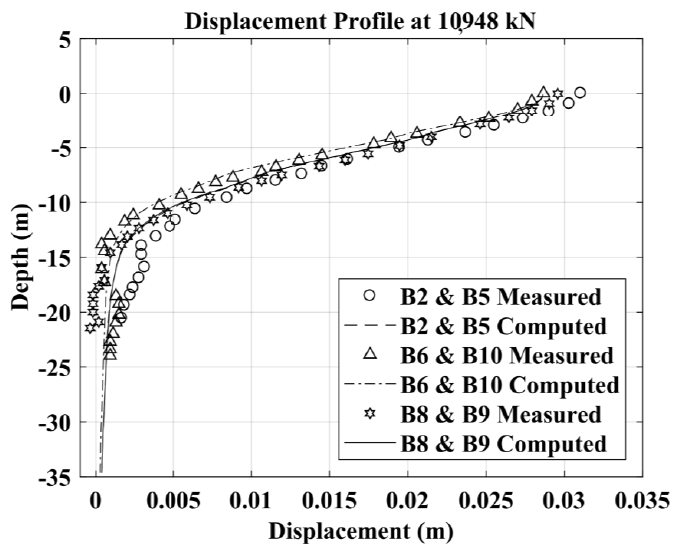
Figure 15. Computed vs. measured group efficiency. Materials 2018 , 8 , 300